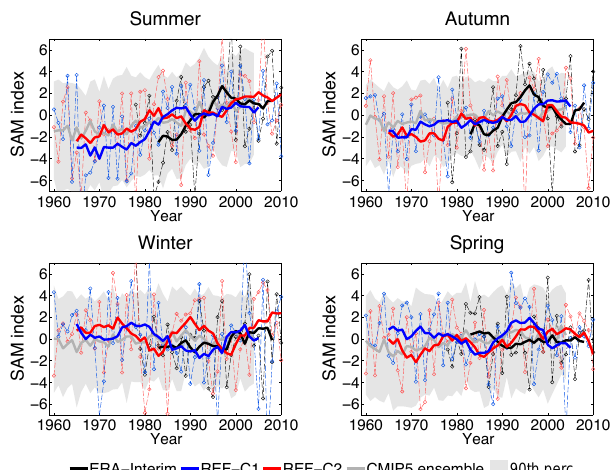
Figure 7. Seasonal SAM indexes for REF-C1 and REF-C2 simu- lations compared to ERA-Interim data and the CMIP5 ensemble. Dashed lines show seasonal averages, while the solid lines have un- dergone a 10-year-running mean of seasonal averages. Shaded re- gions show the 10th and 90th percentiles of the CMIP5